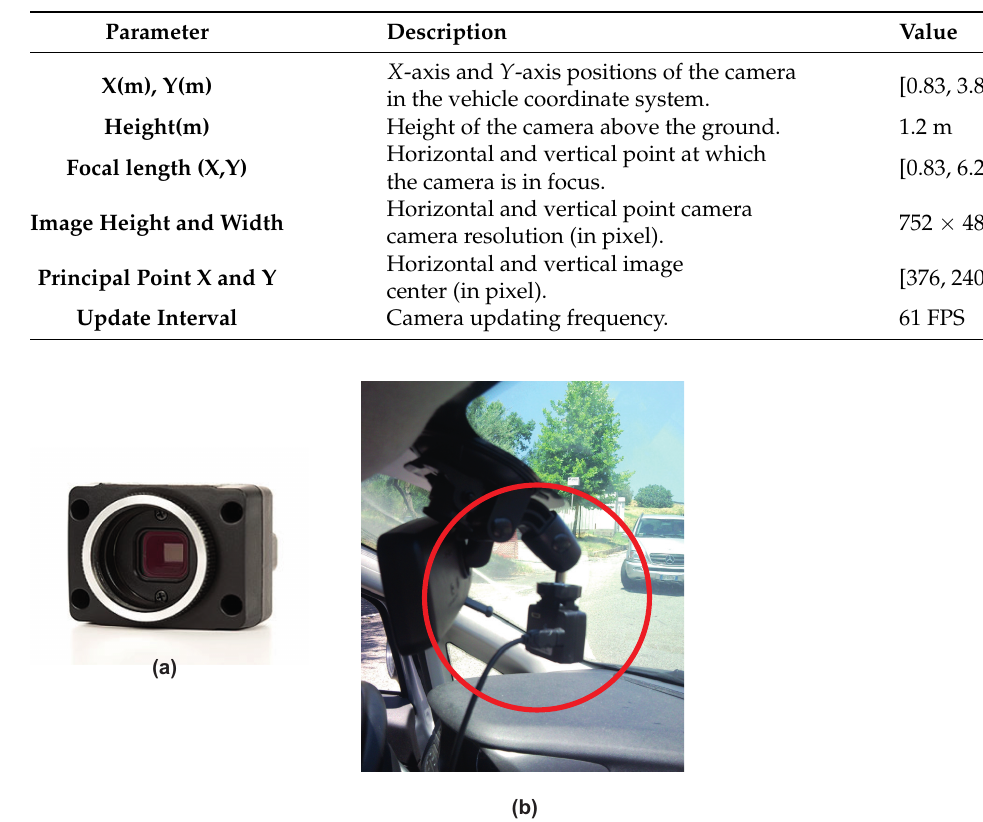
Figure 2. Camera module: reference coordinates ( a ) and ISO convention ( b ). Table 1. Camera parameters.